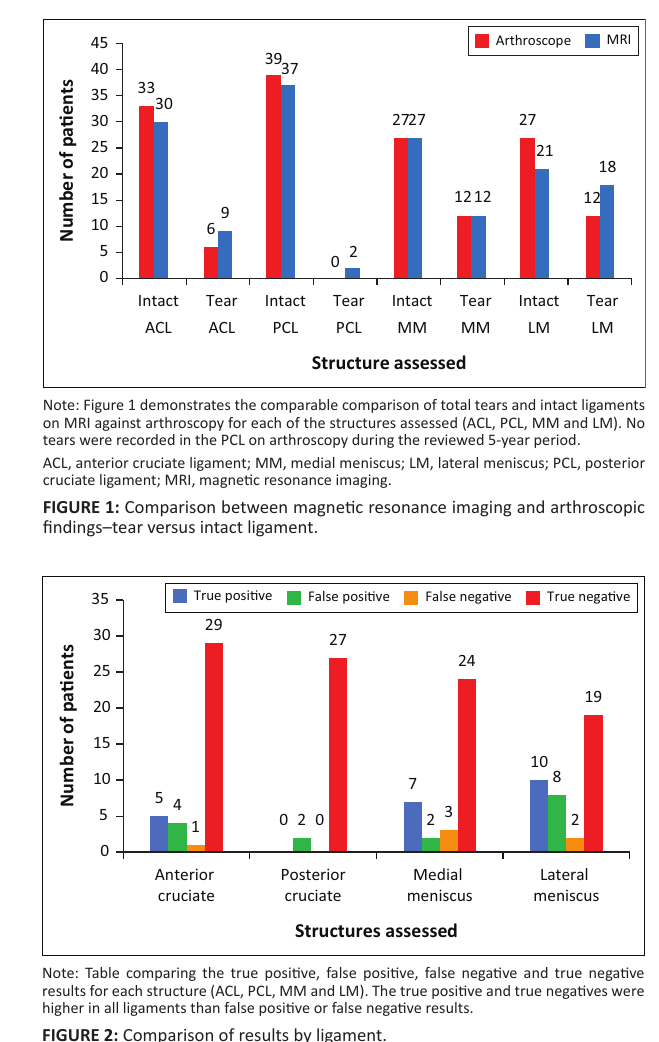
FIGURE 2: Comparison of results by ligament.